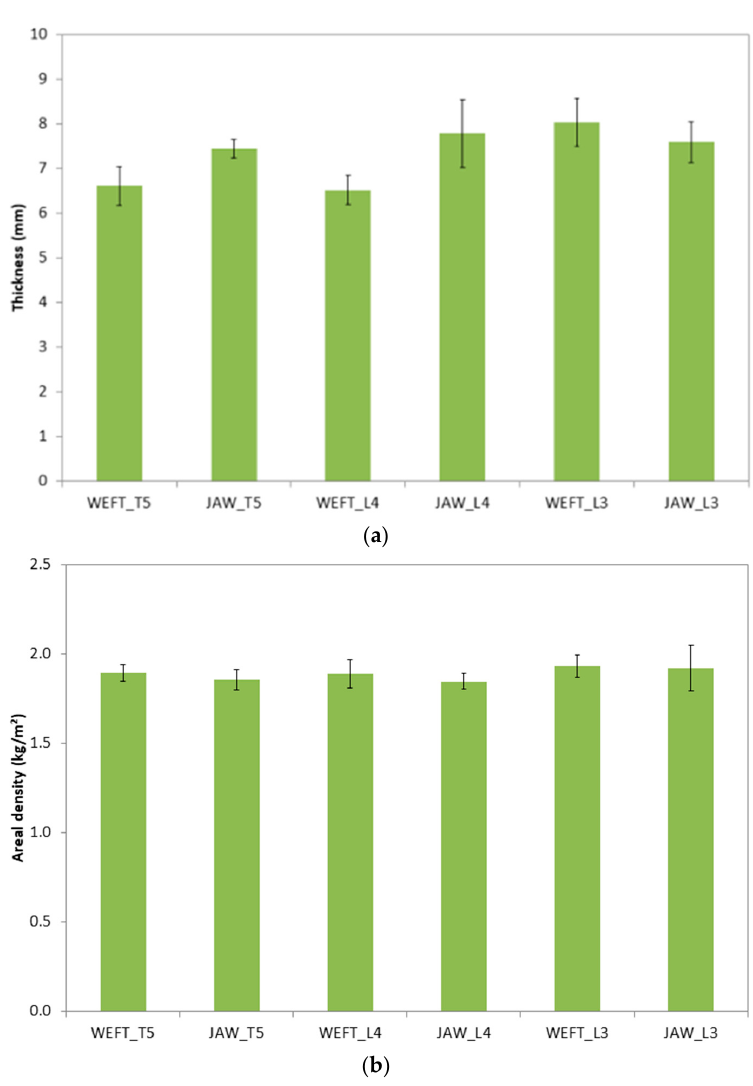
Figure 7. ( a ) Measured thicknesses and ( b ) areal densities of the six different 3D warp interlock fabrics.